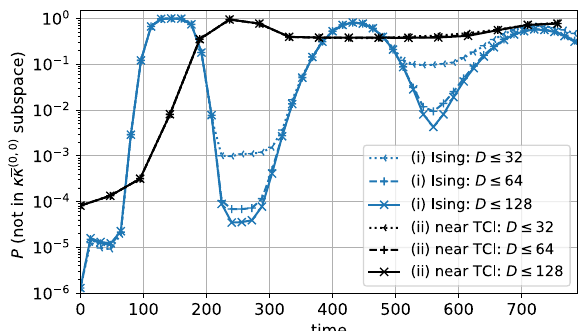
FIG. 9. Dispersion relations (numerical, using MPSs) of kinks κ and mesons μ for λ = 0.41, g = 0.98 in lattice units for Hamiltonian (1). Momentum ranges from − π to π . For mesons, energies are shown with and without a weak longitudinal field. Individual kinks do not have a finite energy for h > 0. Thresh- old energies for pair production are shown (computed assuming that h = 0 for kinks and h = 0.001 for mesons), as is the energy (labeled (cid:8) ) of the simulation shown in Fig. 7 for parameter set (ii). The dispersion relations reach their maximum gradient at momentum p (v max ) ≈